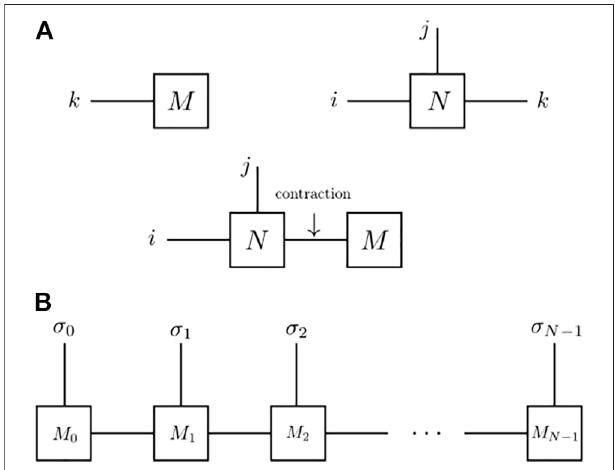
FIGURE 2 | Diagrammatic representations for tensor networks: (A) Diagrammatic representations for tensors M i and N i , j , k , and the contraction between them M i · N i , j , k ; (B) Diagrammatic representation for the one- dimensional tensor network MPS: M j is the local rank-3 tensor and each is contracted via auxiliary bond dimensions (vertical solid lines); σ j is the index for the physical